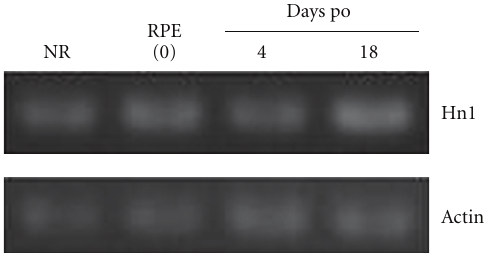
Figure 4: RT-PCR analysis of mouse Hn1 gene after retinal removal. The upper panel shows the expression of mouse Hn1 gene, and the lower panel shows the expression of the β -actin gene as an internal control. Abbreviations indicated as follows: NR: normal retina from adult mice; RPE: retinal pigment epithelium from adult mice; days po: days after operation of retinal